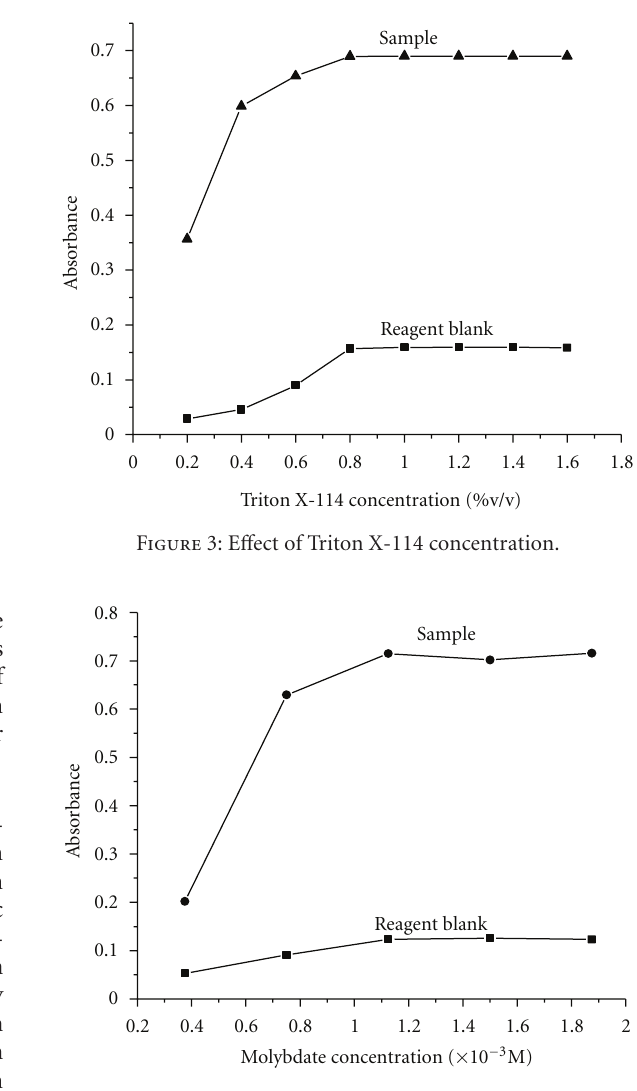
Figure 4: E ff ect of molybdate